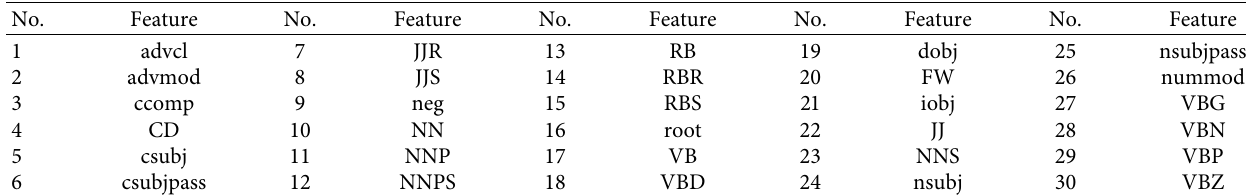
Table 2: Syntactic